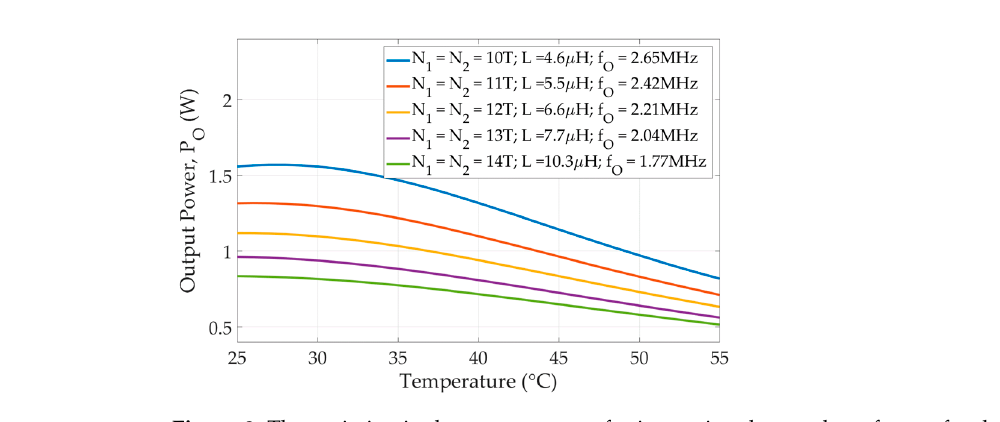
9 of 15 Figure 6. The variation in the output power per load in different temperatures. Furthermore, the simulated results show that a reduction in load resistance can mit- igate the falling slope during the temperature rise. The output power is nearly 1 W for a load resistance of 300 Ω . As a result, increasing the drive voltage can boost the output power and make it more uniform as the temperature rises. However, the input power will also be increased. A variation with the temperature for different drive voltages in the case of the load resistance of 300 Ω is shown in Figure 7a; the input power variation with the drive voltage increasing is shown in Figure 7b. ( a ) ( b ) Figure 7. ( a ) The variation in the output power when the load R L = 300 Ω in different temperatures, and ( b ) the input power variation in the case of the driving voltage increment for fixed load in R L = 300 Ω .